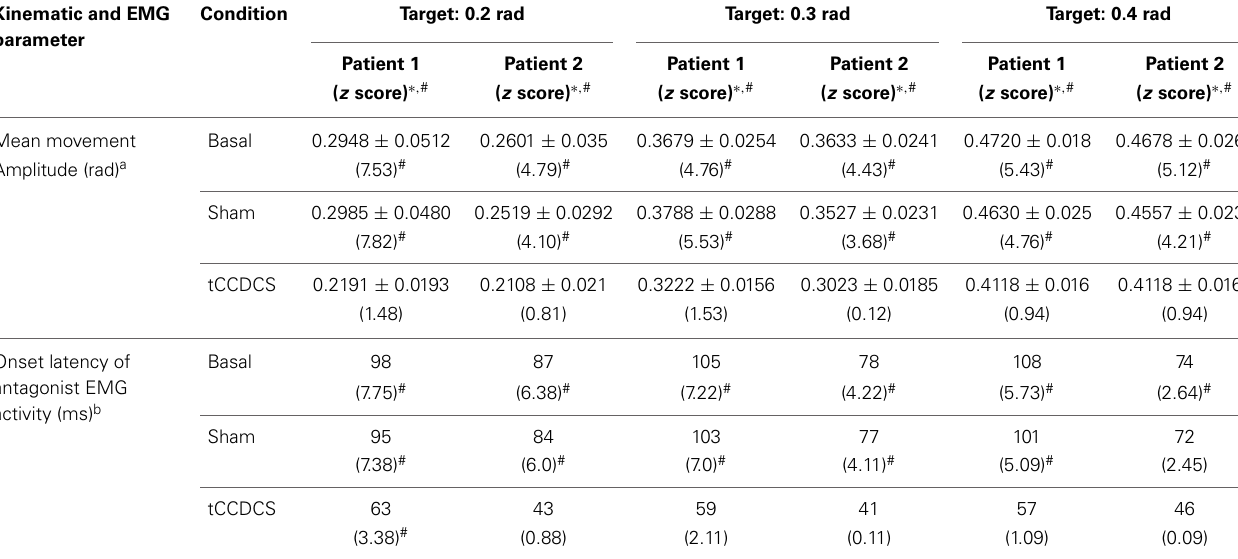
Table 1 | Kinematic and EMG parameters associated with fast goal-directed movements in the 2 patients. Kinematic and